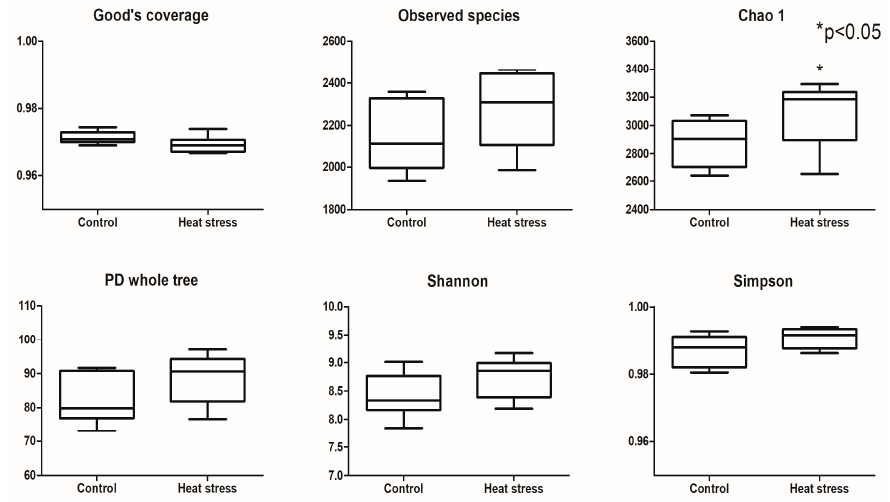
Figure 2. The e ff ects of heat stress on the alpha diversity index of rumen Figure 2. The effects of heat stress on the alpha diversity index of rumen bacteria.